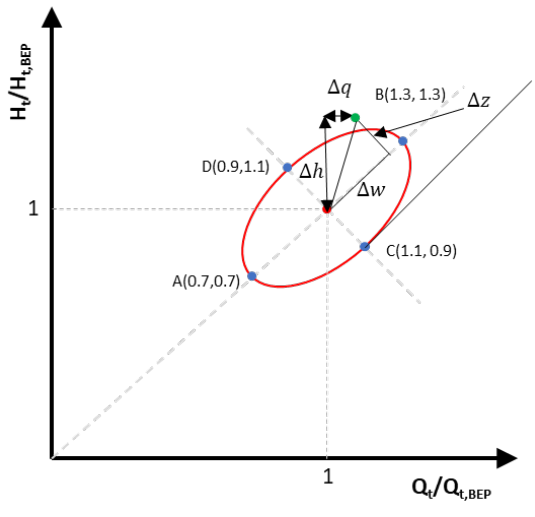
Figure 3. Limits of the acceptable prediction.